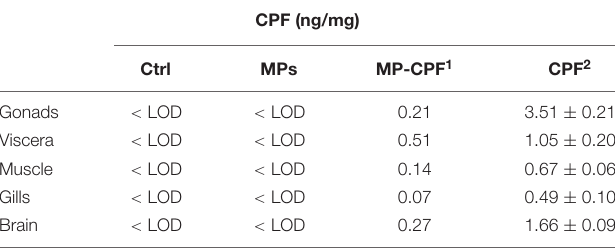
TABLE 1 | CPF concentrations measured in fish organs from different exposure